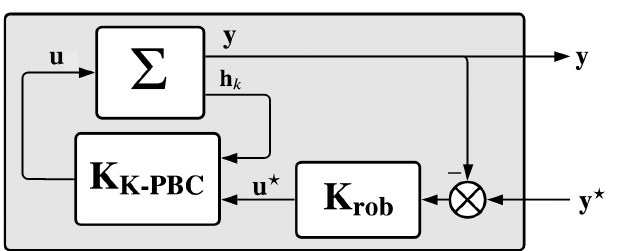
Figure 1. The resulting closed-loop system composed of an inner loop which consists of an LLFT interconnection between the plant Σ and K-PBC, ensuring the passivity of the closed-loop inner system, along with an outer loop containing a dynamic path planning represented by the robust controller K rob designed to ensure robust